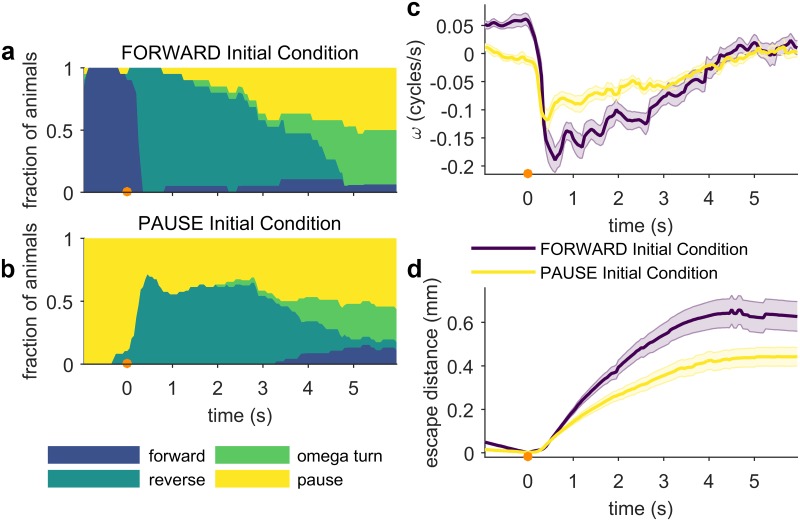
Sensorimotor processing and escape behaviors depend on the animal’s behavioral state prior to the stimulus.Stimulus (133 ms 95 mA, focused by 100 mm lens) is at t = 0 s (indicated by an orange circle). (a-b) Fraction of animals in each behavioral state, separated by initial condition (FORWARD n ≥ 15; PAUSE n ≥ 56). Note the much larger proportion of FORWARD initial condition animals that reverse in response to the stimulus, and the extended length of those reversals. (c) The population mean phase velocity, separated by initial behavioral condition. Animals moving forward before the stimulus are averaged in purple, animals that are paused in yellow. Shaded regions indicate the standard error of the mean at each time point. (d) Mean escape distance. Shaded regions indicate the standard error of the mean at each time point. The population of worms moving forward before the stimulus escapes significantly further. Full ethograms shown in S4 Fig.